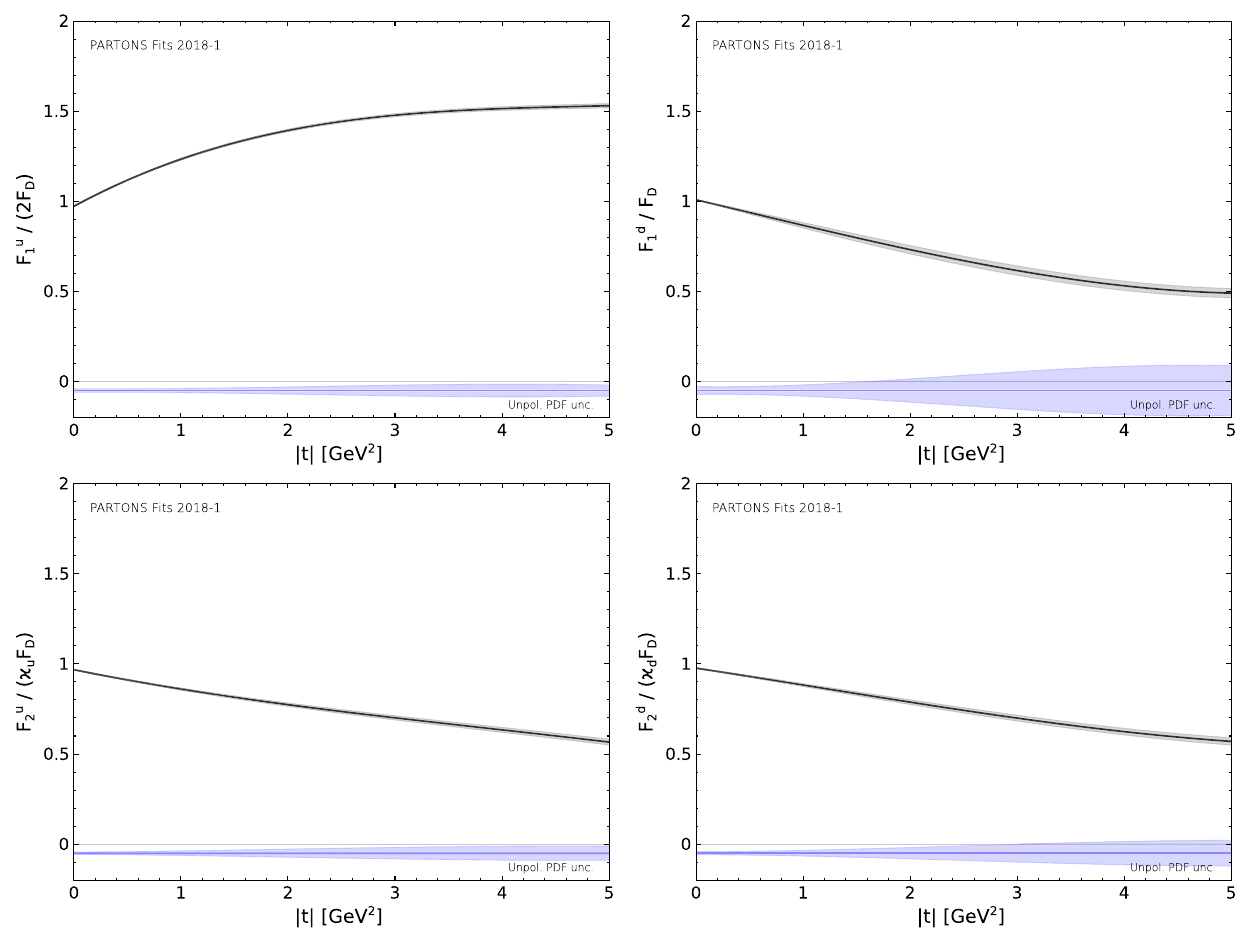
Fig. 5 Parton Dirac and Pauli form factors obtained in this analysis. For further description see Fig.